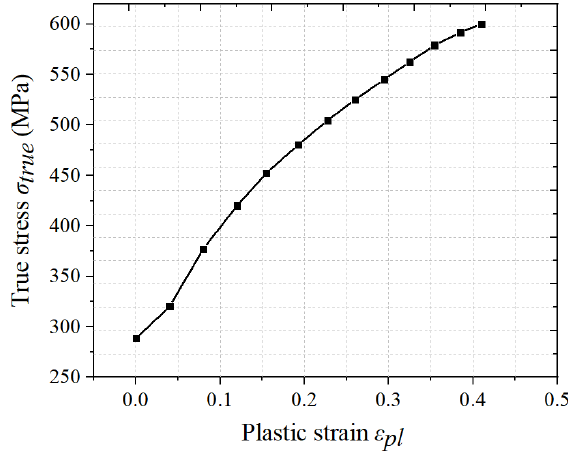
Figure 1. Roll-forming model.